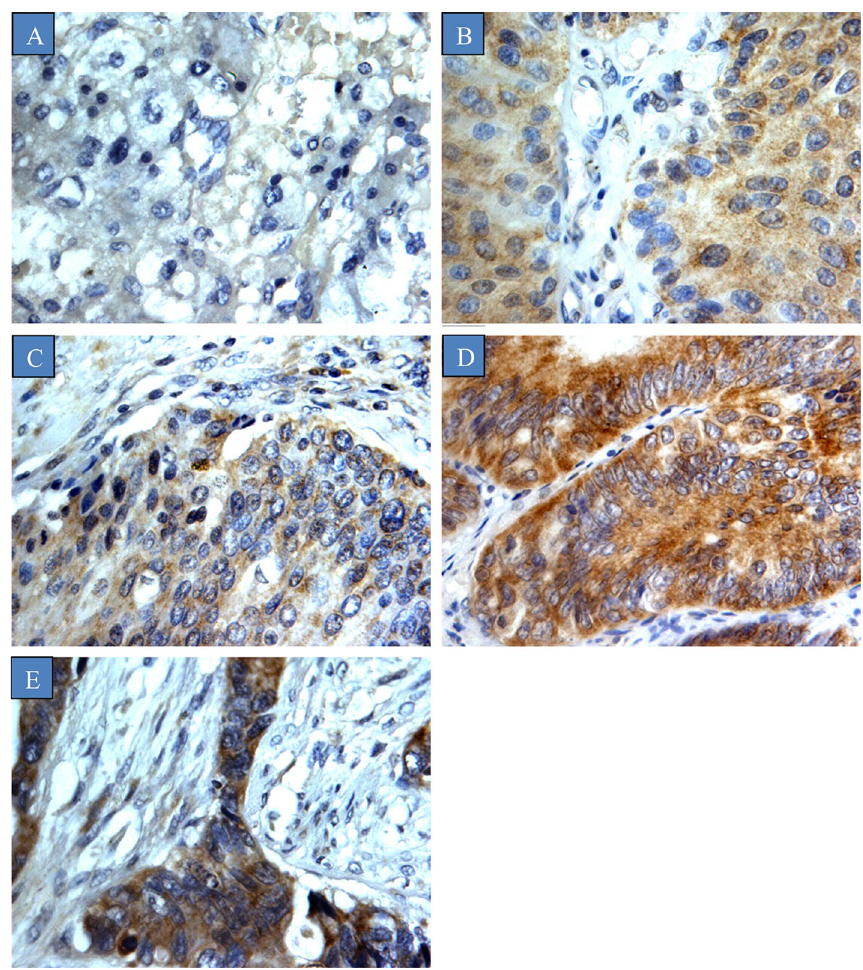
Papillary adenocarcinoma, and ( E ) Mucinous